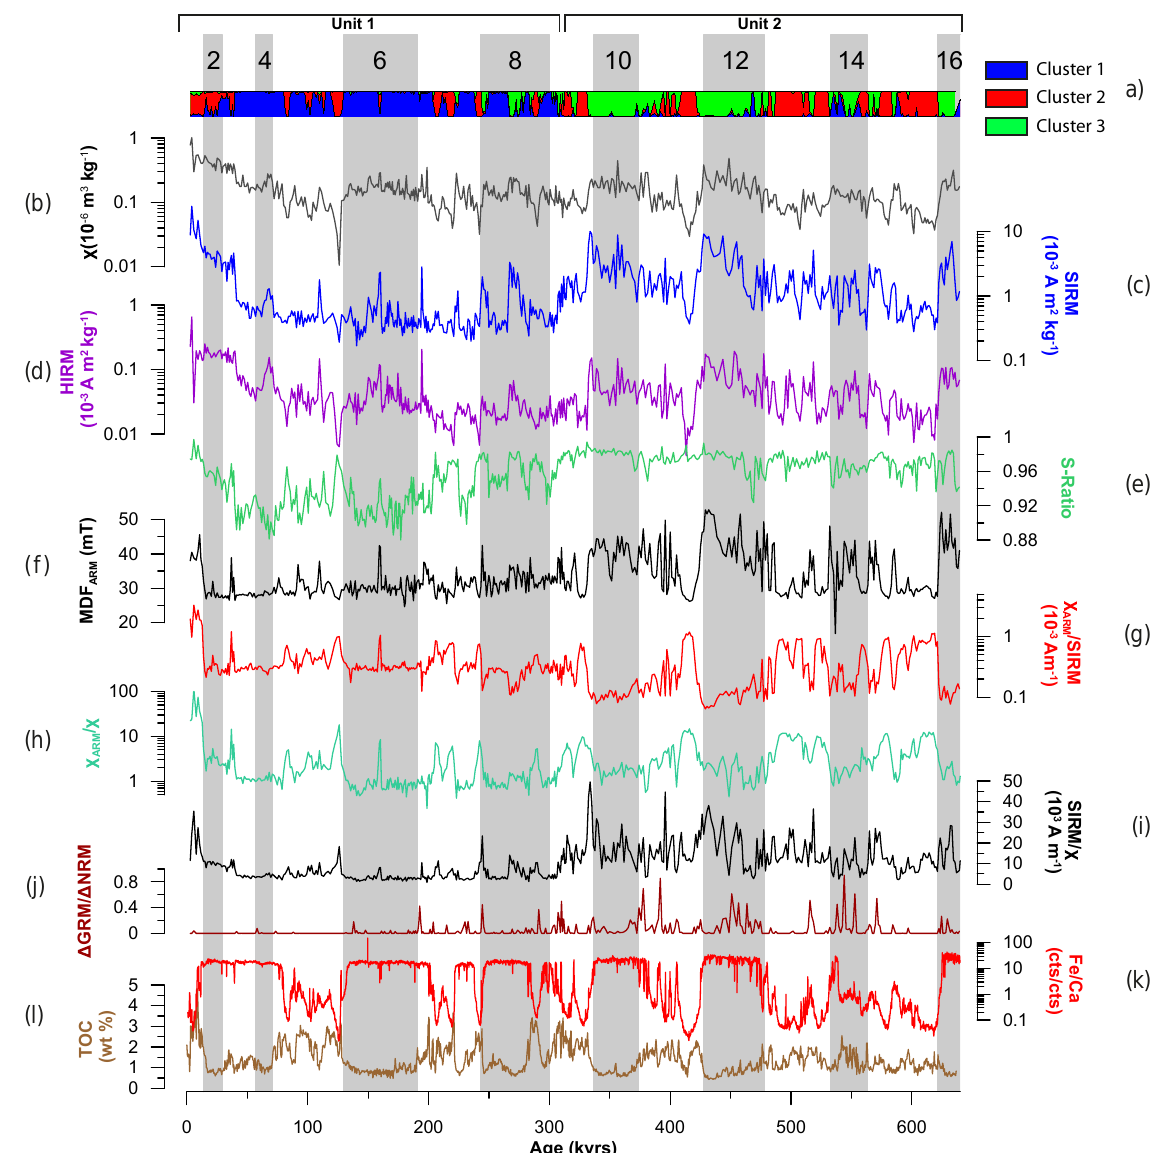
Figure 2. Compilation of magnetic and geochemical parameters measured on samples from the DEEP site. (a) Color bar indicates cluster- membership coefficients for each sample corresponding clusters in Table 2. (d–j) Rock-magnetic proxies; for abbreviations see text. (k) XRF scanning Fe / Ca counts. TOC concentrations (l) are from Francke et al. (2015). Gray bars represent marine oxygen isotope stages after Lisiecki and Raymo